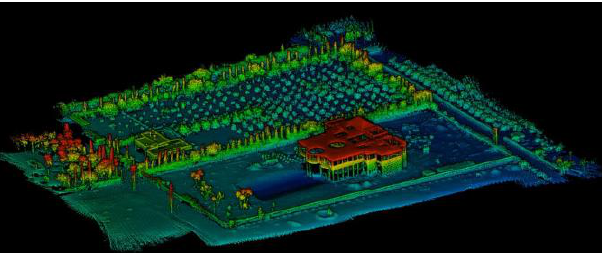
Figure 3 . Point cloud of the study area obtained by Drone- based